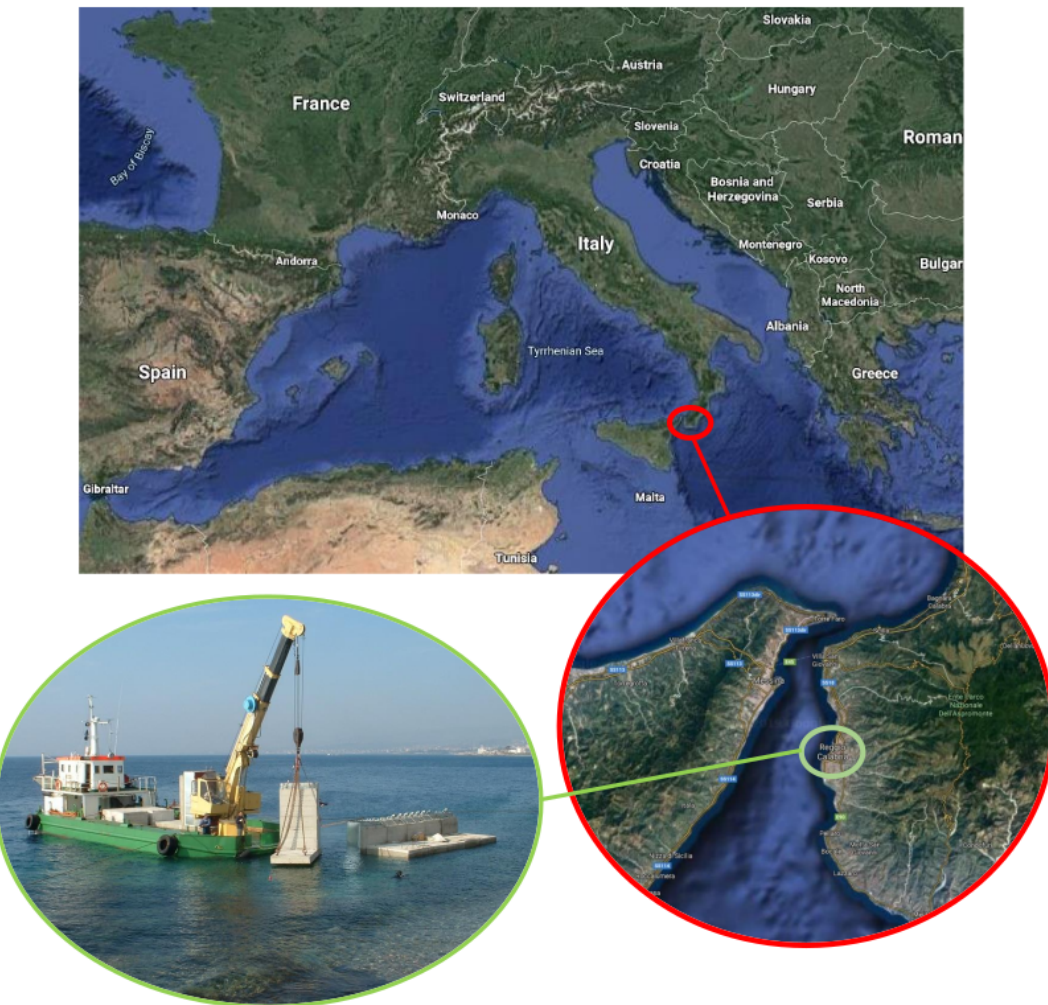
Figure 1. The site of the field experiment (Reggio Calabria, Eastern coast of the strait of Messina) and the positioning of the U-OWC [38 ◦ 06 (cid:48) 32.94 (cid:48)(cid:48) N 15 ◦ 38 (cid:48) 27.6 (cid:48)(cid:48)